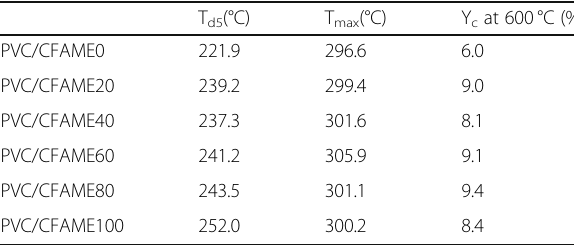
Table 4 TGA data of PVC/CFAME x coatings